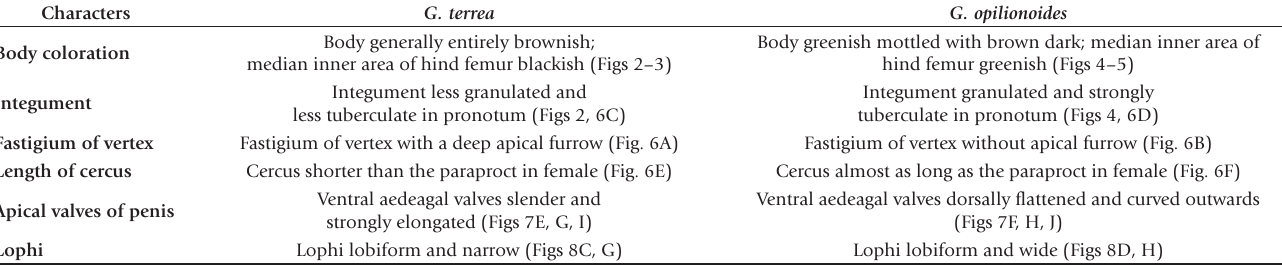
Fig. 3. G. terrea, male from Mpanga forest, Uganda (2°97'78"N, Table 2. Tabular key to species.